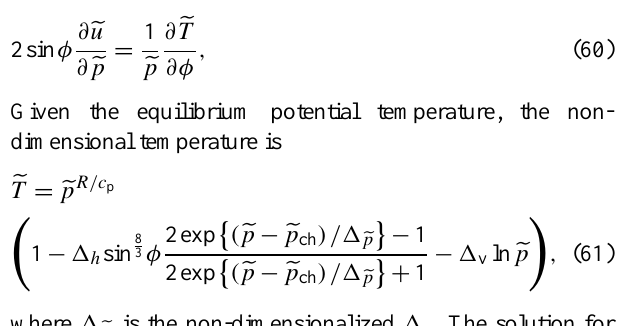
are perturbed. e p